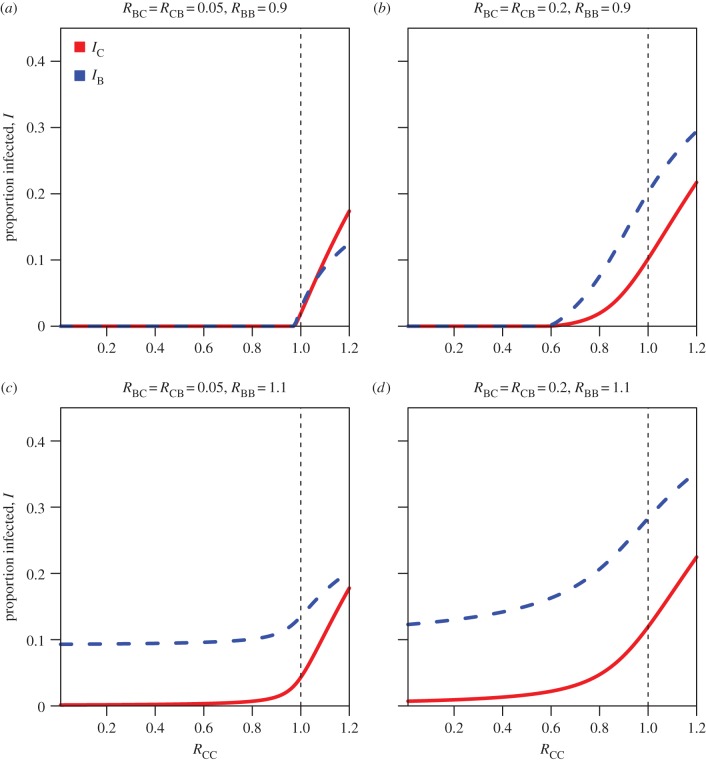
Four scenarios for bovine tuberculosis transmission between cattle and badgers in Great Britain. The horizontal axis RCC is the number of secondary cases in cattle due directly to cattle and the vertical axis is the proportion of infected cattle (red) and infected badgers (blue) at equilibrium. RBC, RCB and RBB are the number of secondary cases in cattle due to badgers, in badgers due to cattle and in badgers due to badgers (see main text for details). The four scenarios are: (a) low inter-species transmission and unsustained transmission in badgers; (b) intermediate inter-species transmission and unsustained transmission in badgers; (c) low inter-species transmission and sustained transmission in badgers; and (d) intermediate inter-species transmission and sustained transmission in badgers.